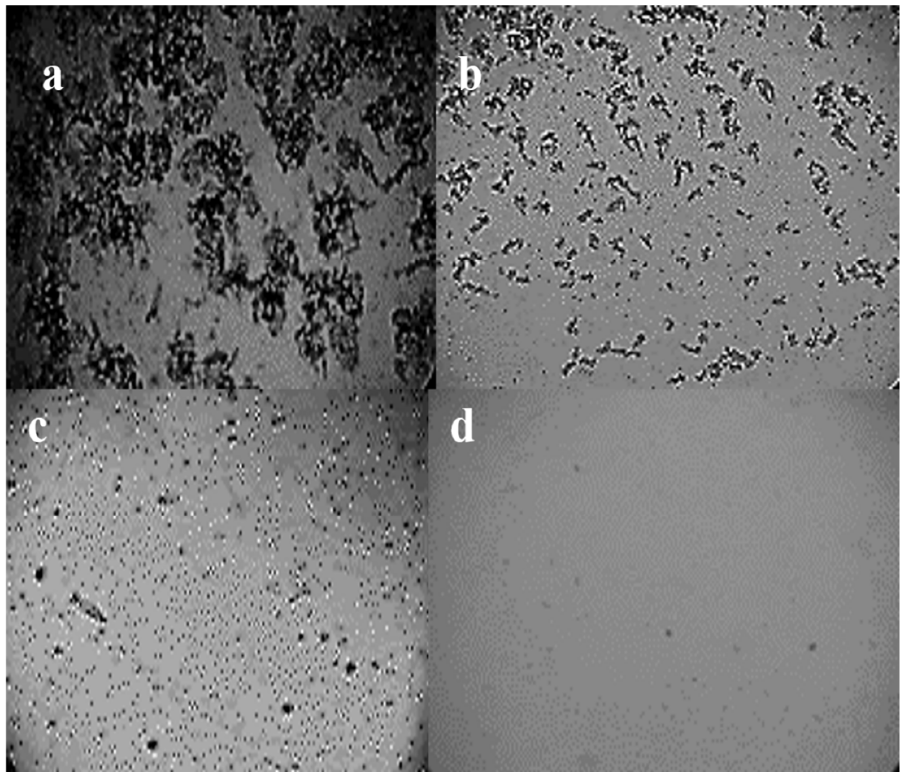
Figure 8. Photographs of paraffin crystals from waxy crude oil untreated ( a ) and treated with PBOCODSA (500 ( b ), 1000 ( c ),and 2000 ( d ) ppm).